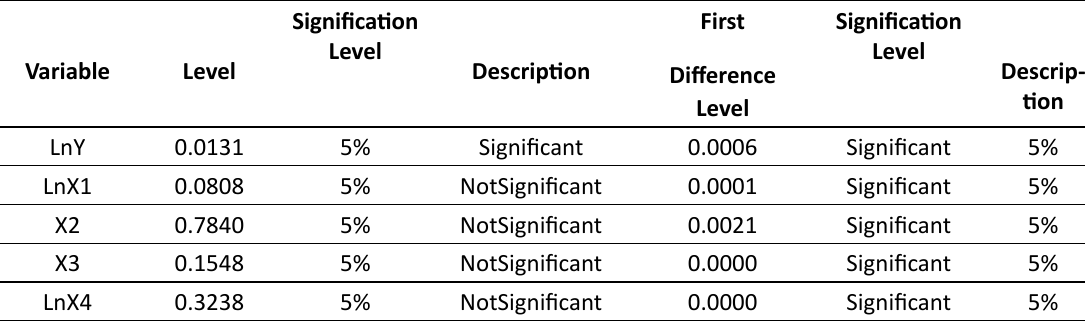
Table 1: Level Station Testing and First